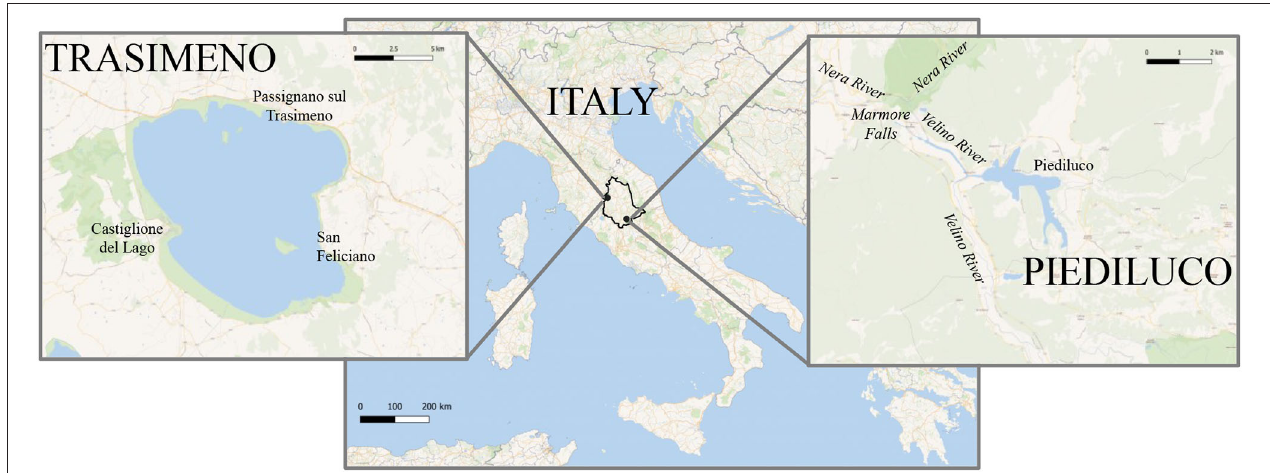
FIGURE 1 | Map of the sampling areas: Trasimeno and Piediluco lakes, located in Central Italy (Umbria